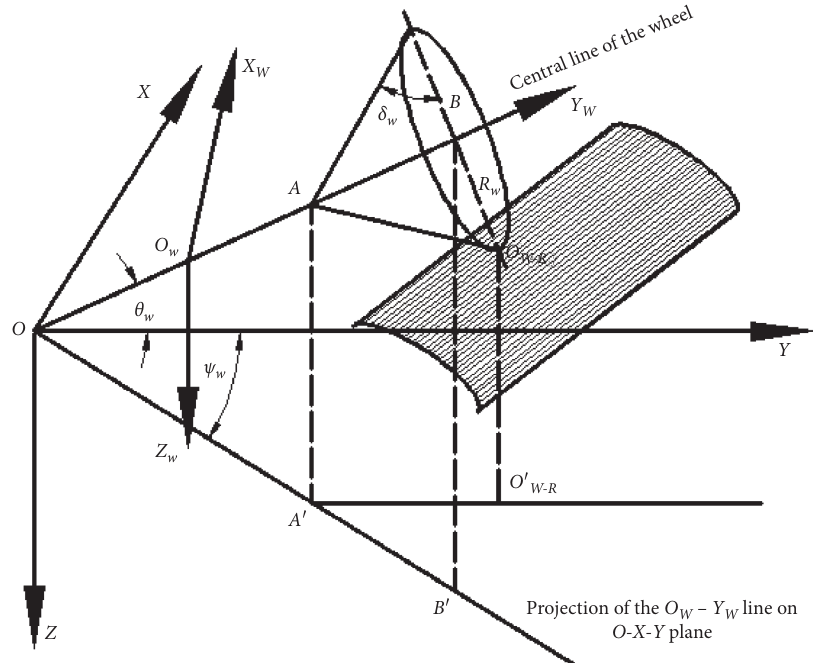
Figure 4: Wheel-rail solid contact model [6].